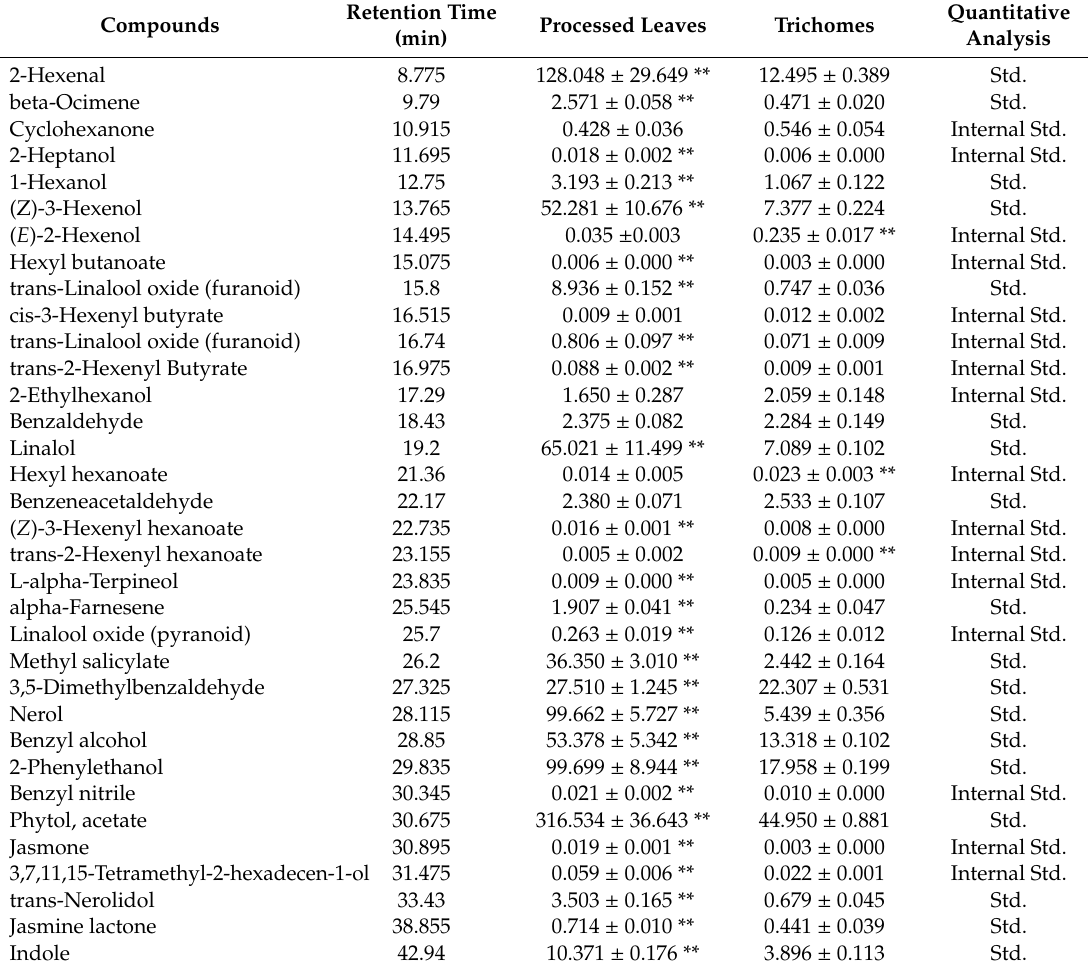
Table 3. Contents of the main aroma compounds in fresh trichomes and processed leaves (nmol / g fresh